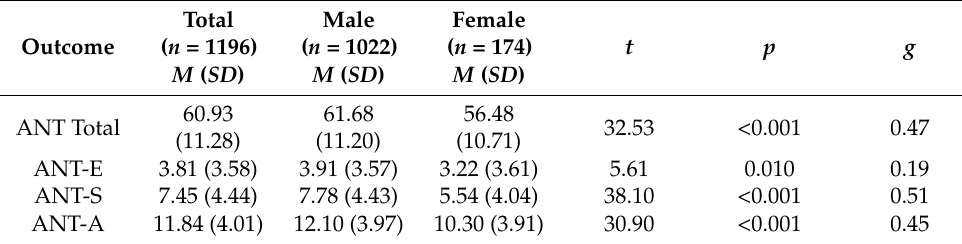
Table 1. Antisocial Personality Disorder Features by Gender.